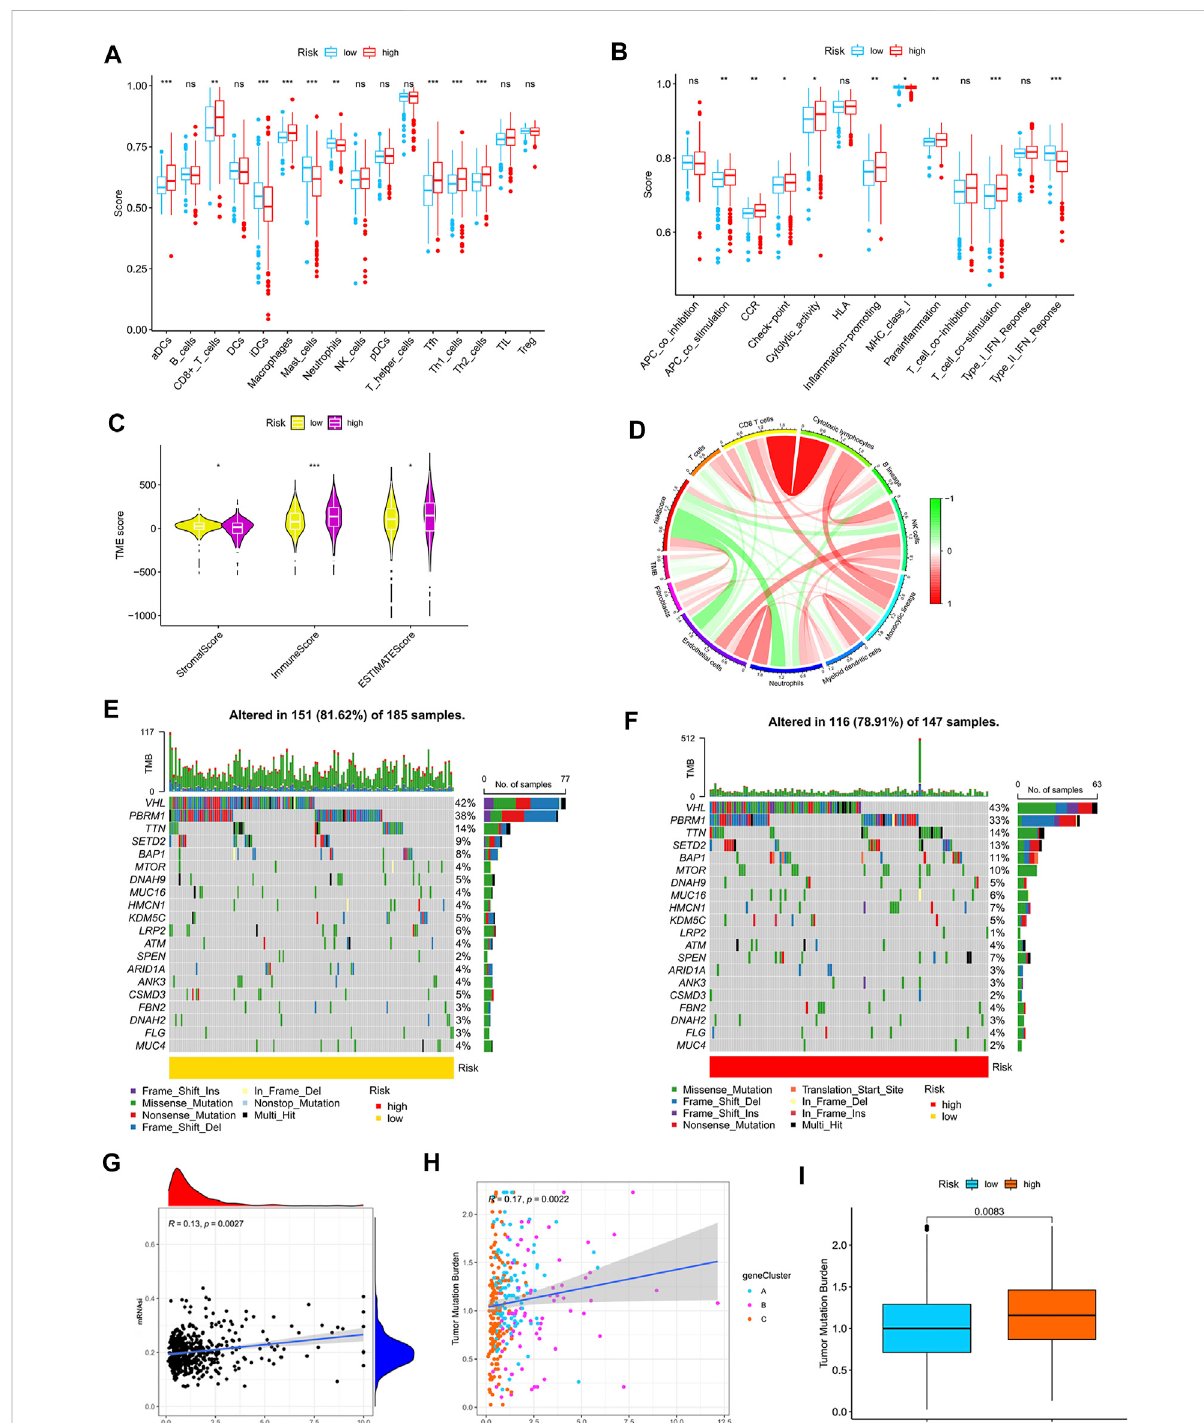
FIGURE 6 Relationship between the m7G score and tumor immune microenvironment. (A,B) ssGSEA of the correlation of the m7G score with immune cells and immune function. (C) ESTIMATE algorithm analysis of the correlation of the m7G score with immune cells and immune function. (D) MCP counter algorithm analysis of the correlation between the m7G score and immune cells. (E,F) Mutation characteristics of the high- and low-risk groups. (G) Correlationanalysisbetweenthem7Gscoreandstemnessindices. (H,I) Correlationanalysisbetweenthem7GscoreandTMB.TMB, tumor mutation